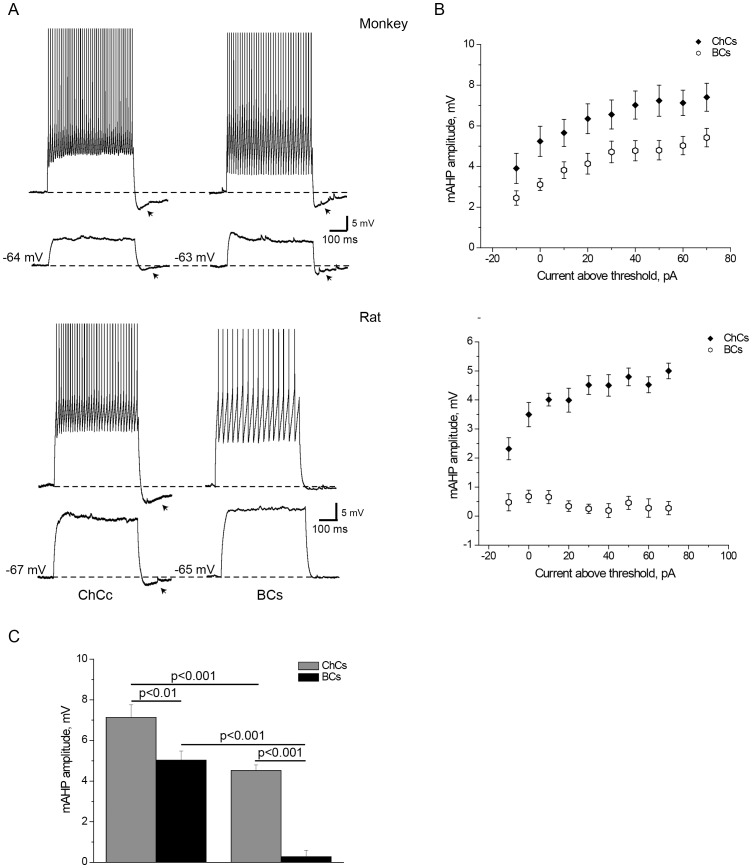
ChCs and BCs differences in mAHP amplitude in rat and monkey.A. Representative traces with sub-and suprathreshold responses to depolarizing current pulses in monkey and rat ChCs and BCs. Arrowheads mark mAHP in monkey ChCs and BCs, as well as in rat ChCs. Note that in rat, mAHP was observed in ChCs, and was almost absent in BCs, while in monkey, mAHP could be observed in both cell types, but was more pronounced in ChCs than in BCs for the same current intensities above rheobase. B. Quantification of population data for mAHP amplitude at different stimulation current intensities. X-axis values: “0 pA” = rheobase, “−10 pA” = current intensity 10 pA below rheobase, all positive values = current above rheobase. C. mAHP amplitude at the stimulation level of 60 pA above rheobase was larger in ChCs than BCs in both species, as well as in monkey than in rat for both ChCs and BCs. Error bars represent SE.